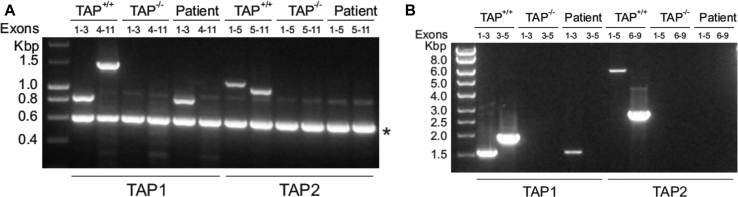
A, RT-PCR of the different exons of TAP1 and TAP2 showing absence of TAP1 genes beyond exon 3 and complete absence of TAP2. RNA was extracted from BLCL of the patient, TAP positive (T0) and TAP-negative (T2) control lines. Tapasin (*) was amplified as a loading control. B, PCR from genomic DNA showing the presence of TAP1 up to exon 3 and the absence of TAP2 in the same cell lines as in Fig E1, A.